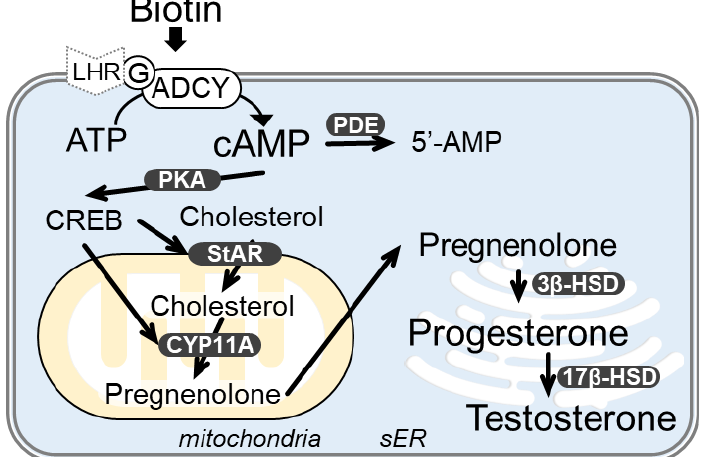
Figure 6. Presumed mechanism of biotin on the enhancement of testosterone production in I-10 cells. 3 β -HSD, 3 β -hydroxysteroid dehydrogenase; 17 β -HSD, 17 β -hydroxysteroid dehydrogenase; ADCY, adenylate cyclase; cAMP, 3 ′ , 5 ′ -cyclic adenosine monophosphate; CREB, cAMP response element-binding protein; CYP11A, cytochrome P450 cholesterol side chain cleavage enzyme; PKA, protein kinase A; sER, smooth endoplasmic reticulum; StAR, steroidogenic acute regulatory protein.